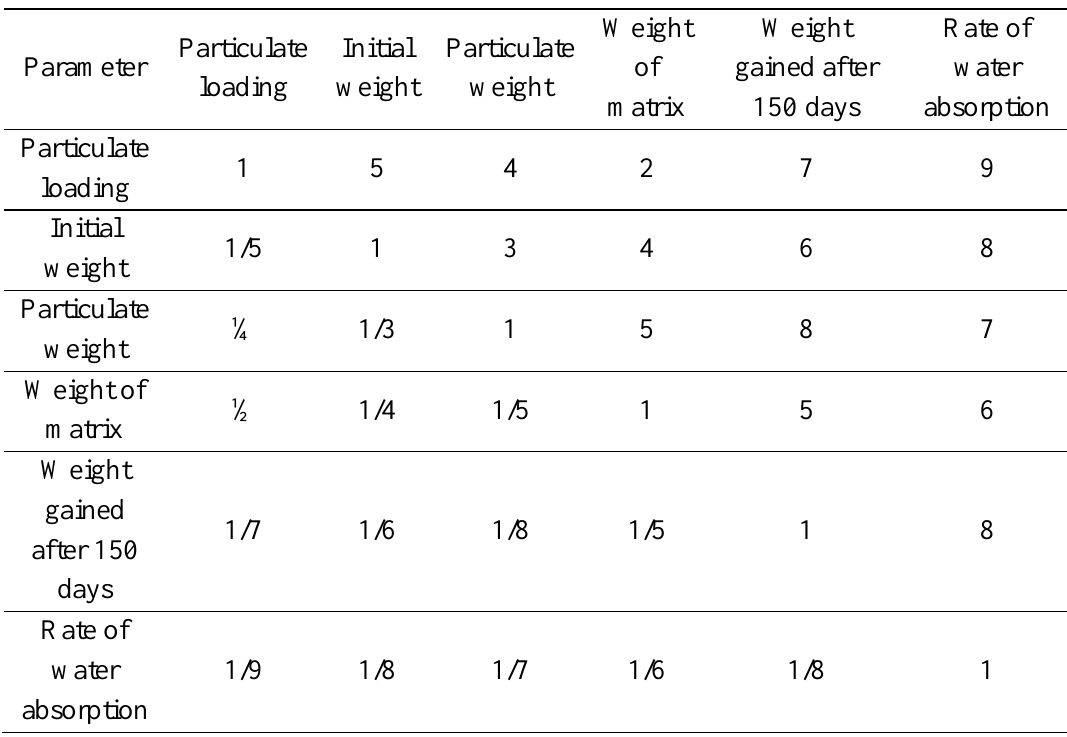
Table 8. The 6 x 6 matrix representing the values of the pairwise comparison for the cocoa pod husk